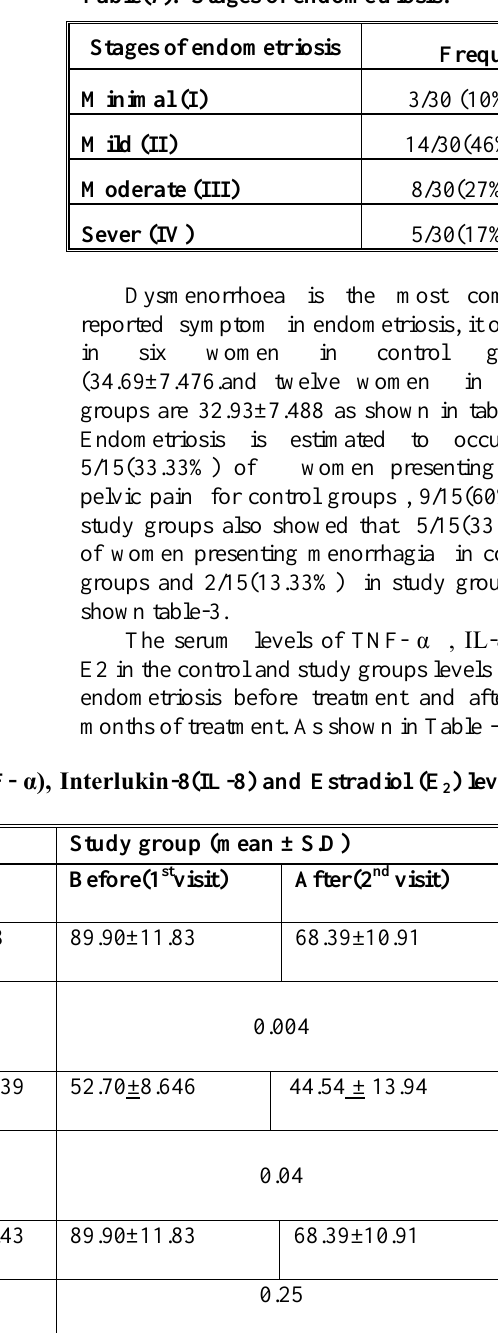
Table(7): Stages of endometriosis.